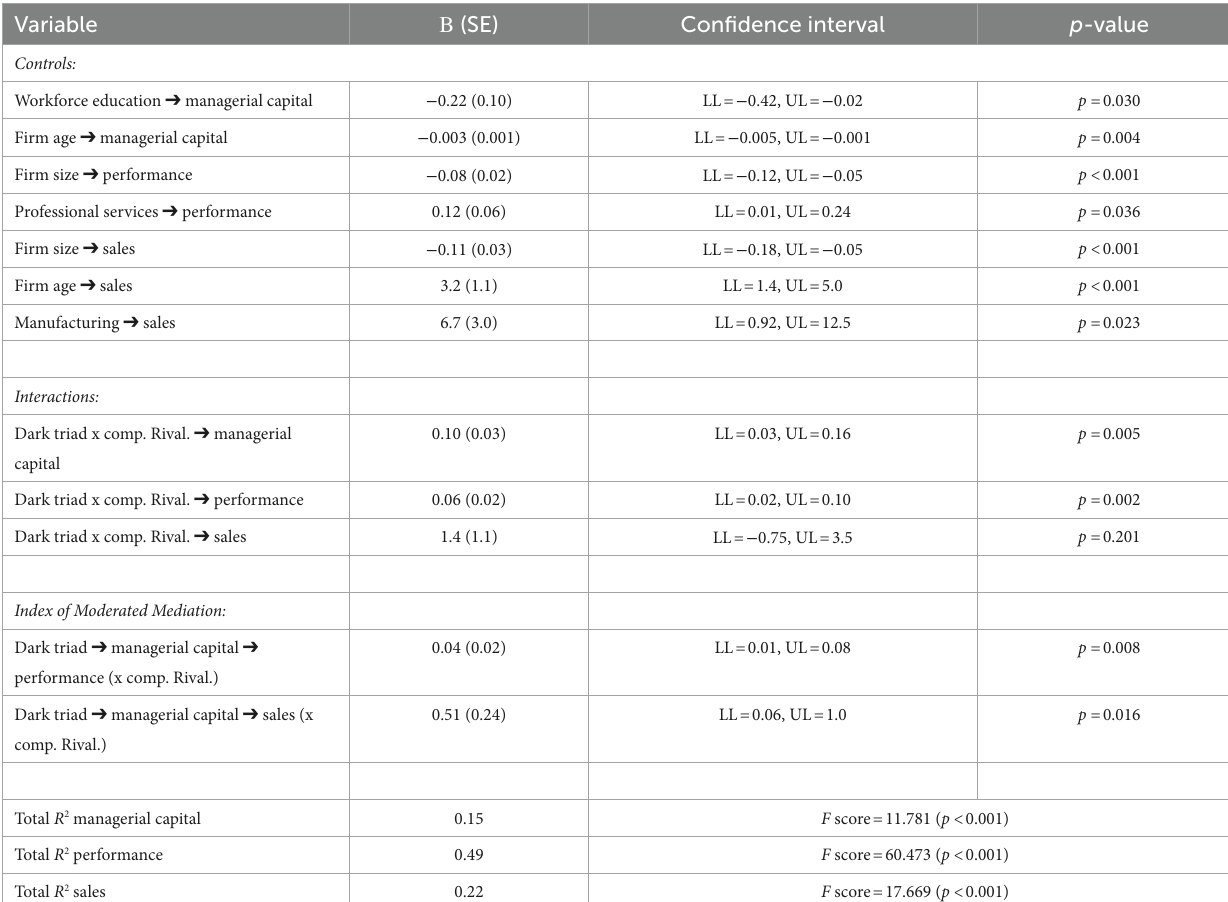
TABLE 3 Results of moderated regression analyses. Variable Β (SE) Confidence interval p